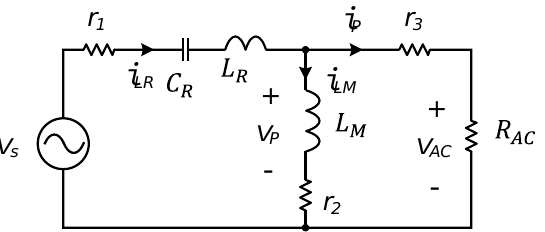
Figure 4. Equivalent circuit for each state of the LLC resonant converter in steady-state: ( a ) When switch S1 is turned on; and ( b ) when switch S2 is turned on.